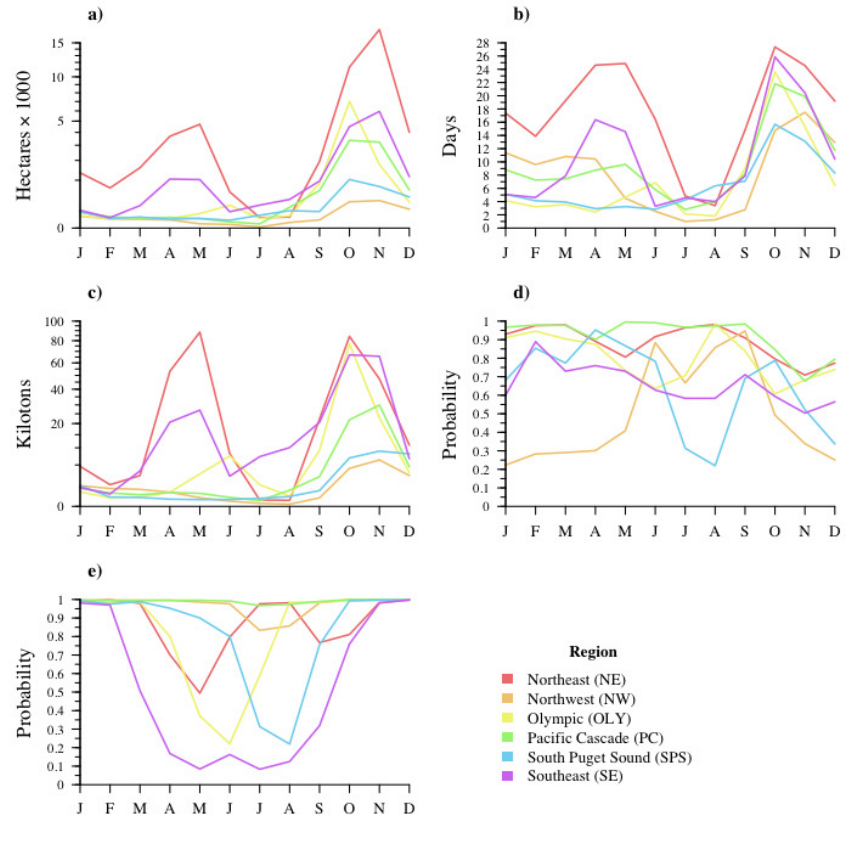
Figure 6. SeasonalprofileoffiveprescribedfirevariablesforeachDNRadministrativeregioninWashington State. There is one panel for each prescribed fire parameter: burned area ( a ), number of burn days ( b ), burned biomass ( c ), approval probability ( d ), and pile probability ( e ). Area burned and biomass burned were square-root transformed for visualization purposes.